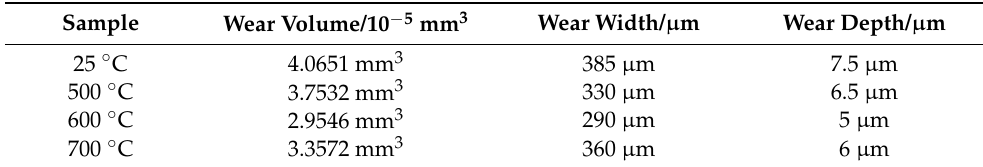
Figure 8. Wear volume and curves of width and depth of scratch: ( a ) wear volume; ( b ) width and depth of the scratches. Table 3. The wear volume, width, and depth of coatings.